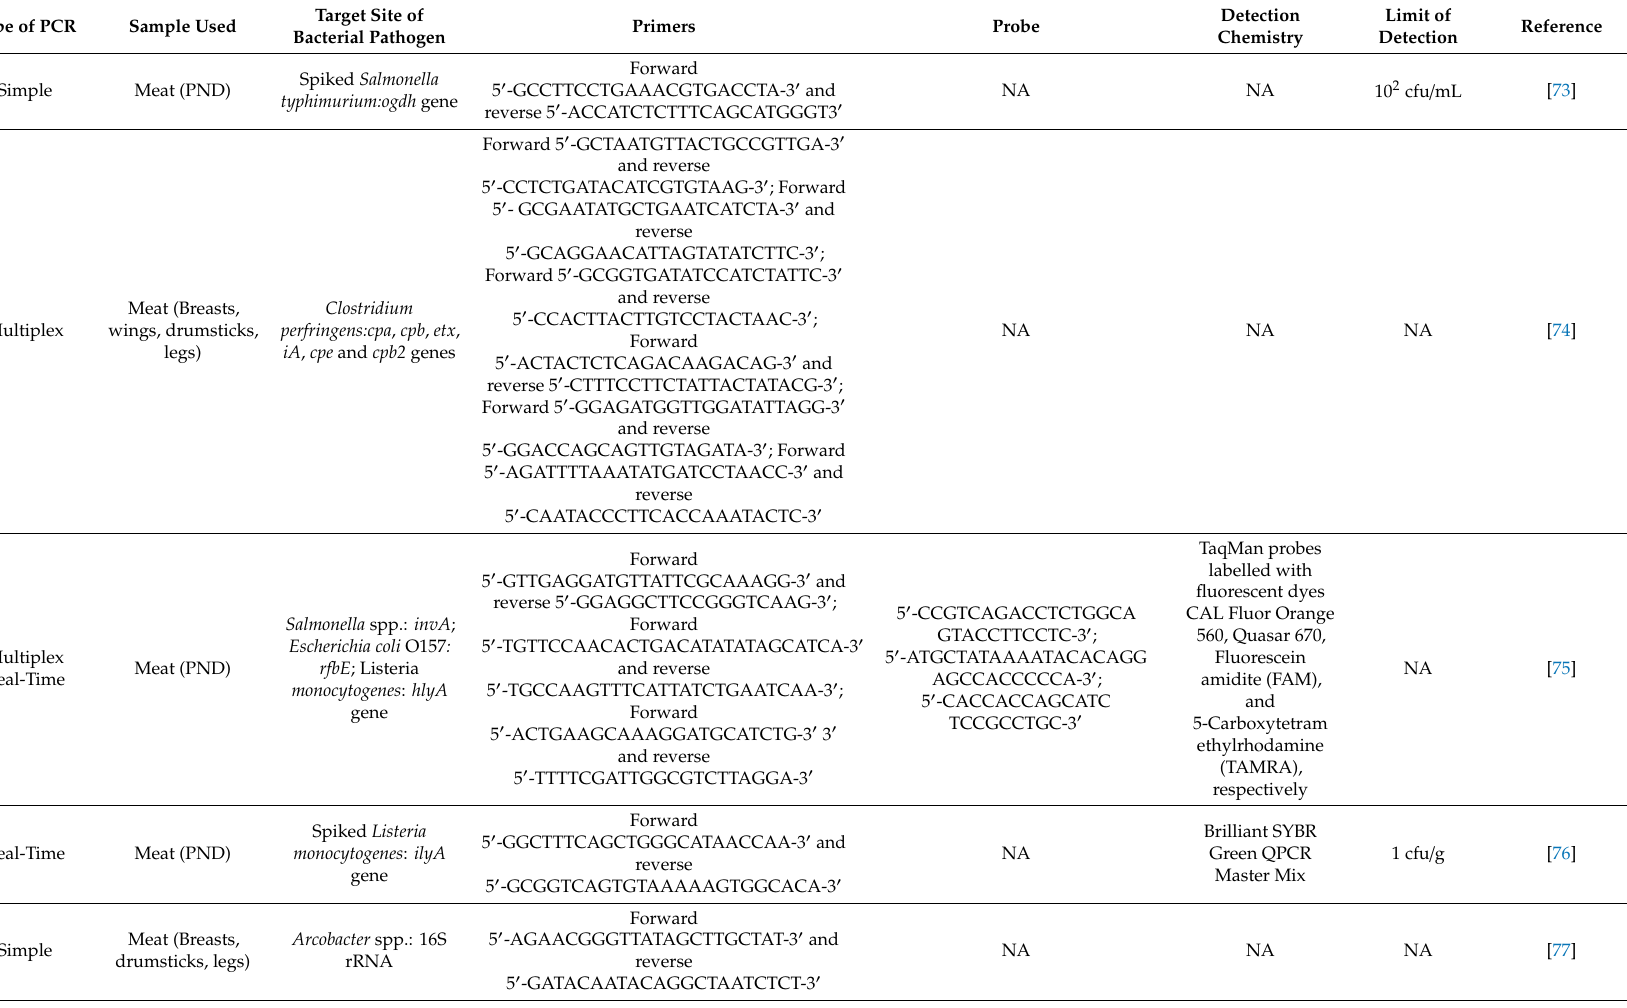
Table 4. PCR approaches used for the detection of chicken-borne